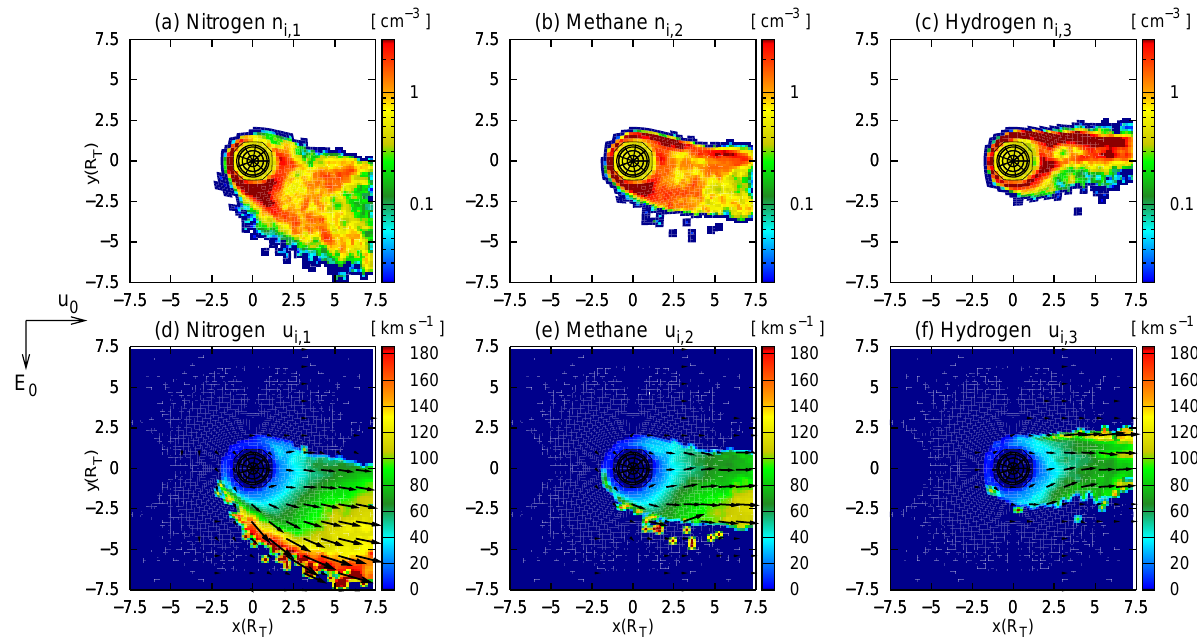
Fig. 2. Run #1 : Titan’s plasma environment at 18:00 Saturnian local time. The figure shows the ionospheric plasma parameters for a cut through Titan’s equatorial plane. Specifically, the figure displays the densities (a) of molecular nitrogen ions (subscript i, 1 ), (b) of methane ions (subscript i, 2 ) and (c) of molecular hydrogen ions (subscript i, 3 ). The corresponding plasma velocities are shown in plots (d) to (f). Near the outer flank of the tail in the ( y < 0) hemisphere, where the ions are strongly accelerated, their densities can practically be neglected. The figure has been obtained from Simon et al. (2007b).